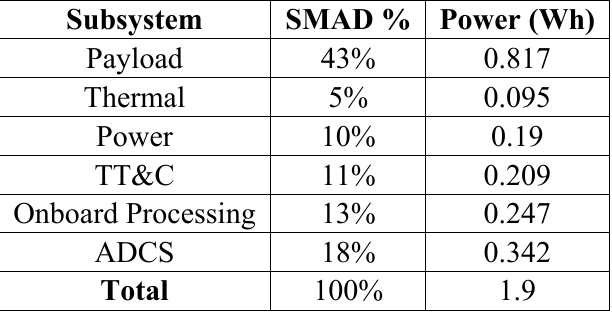
Table 8. Power Budget [11].